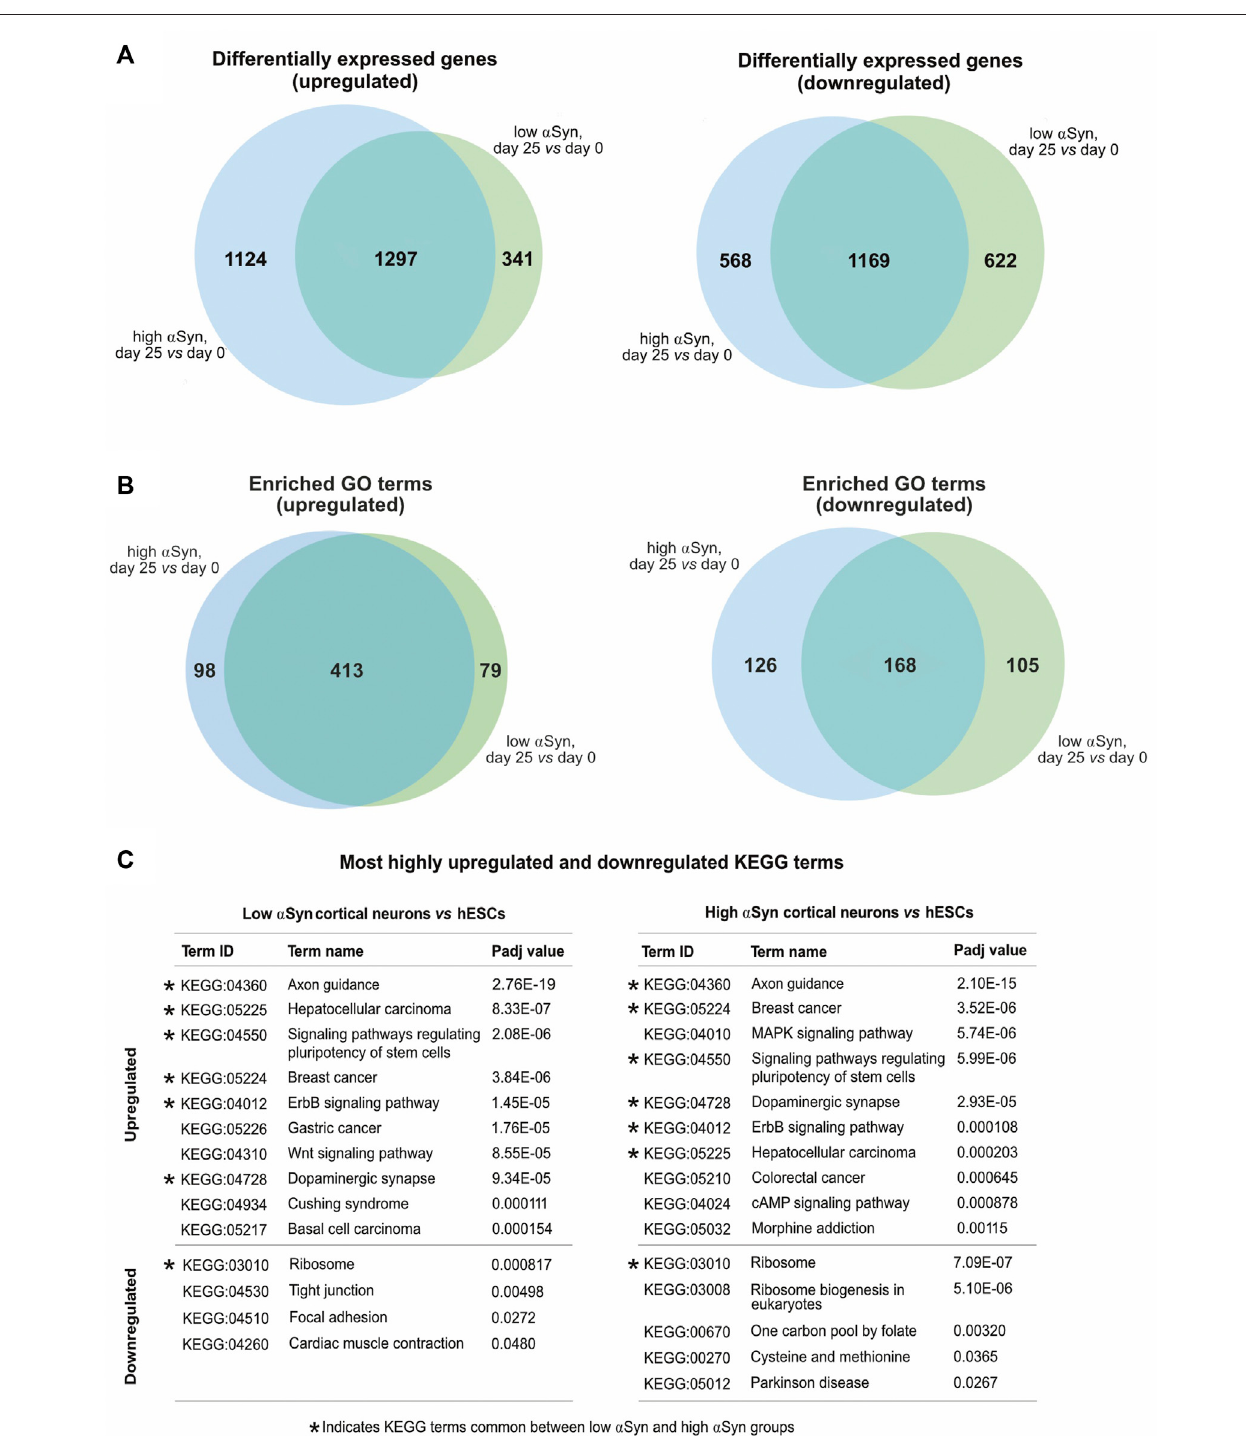
FIGURE7|(A) Venn diagramscomparing upregulated and downregulateddifferentially expressed genesfrom low α Syncorticalneurons vs hESCsandhigh α Syn cortical neurons vs hESCs comparisons. (B) Venn diagrams comparing upregulated and downregulated GO terms from low α Syn cortical neurons vs hESCs and high α Syn cortical neurons vs hESCs comparisons. (C) List of top 10 upregulated and top 10 downregulated KEGG terms by Padj value, in order of ascending Padj, for low α Syn cortical neurons vs hESCs and high α Syn cortical neurons vs hESCs (if less than 10, all terms shown). KEGG terms common to both comparisons are